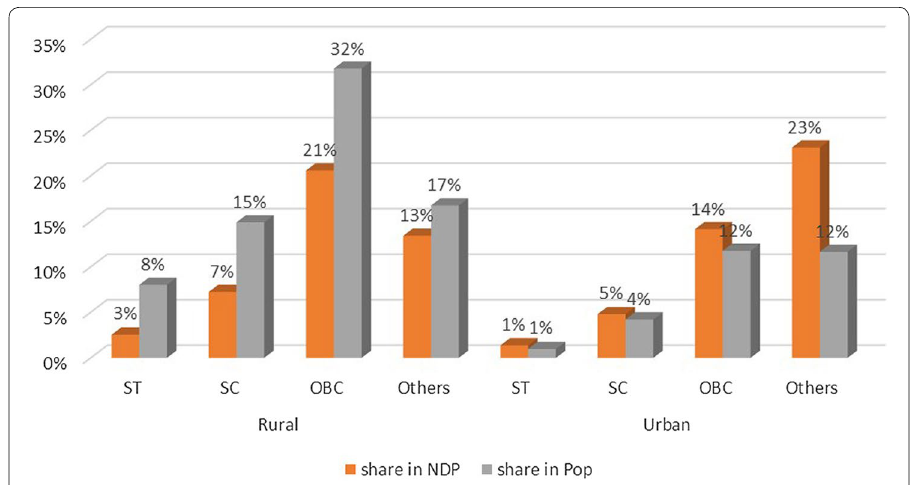
Fig. 1 Households categorywise share in population and net domestic